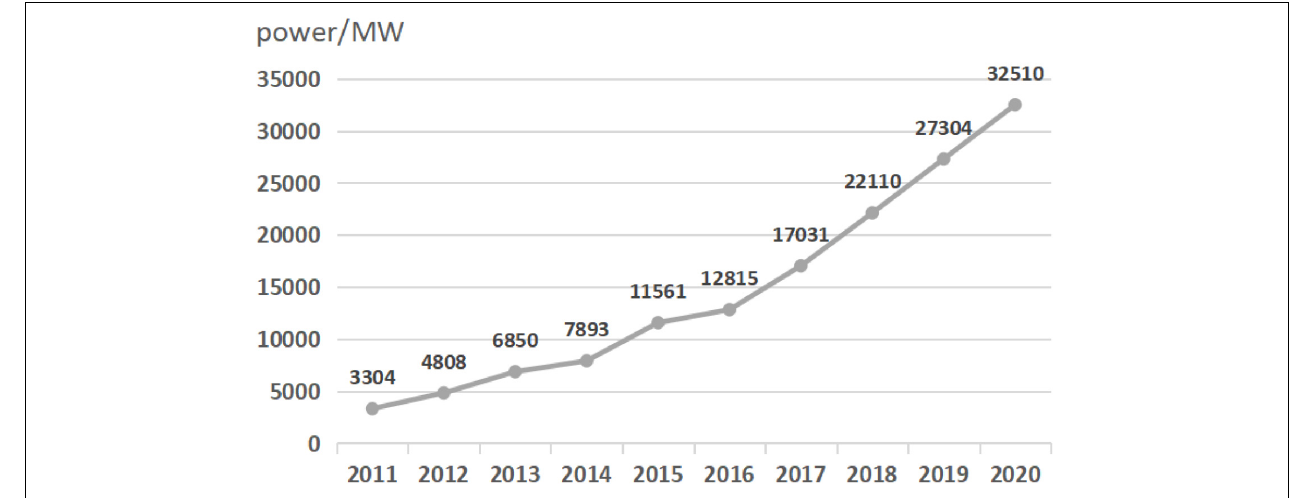
FIGURE 1 | The installed capacity of offshore wind power in the past